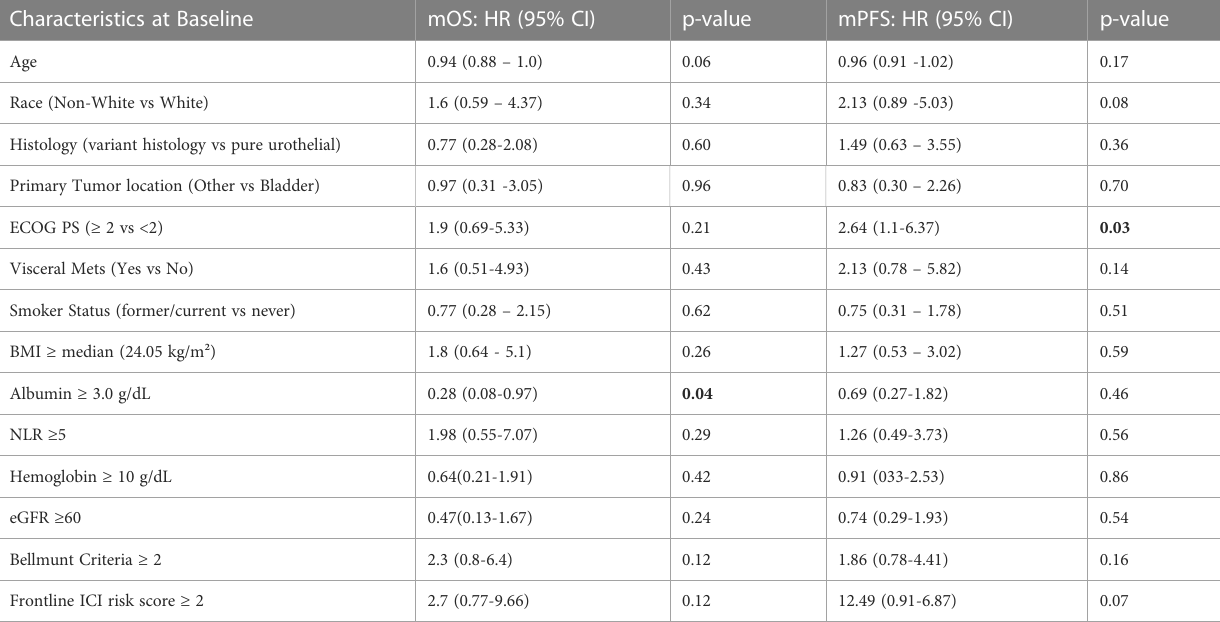
TABLE 5 Clinical Characteristics - Univariable analysis of progression-free survival and overall survival. Characteristics at